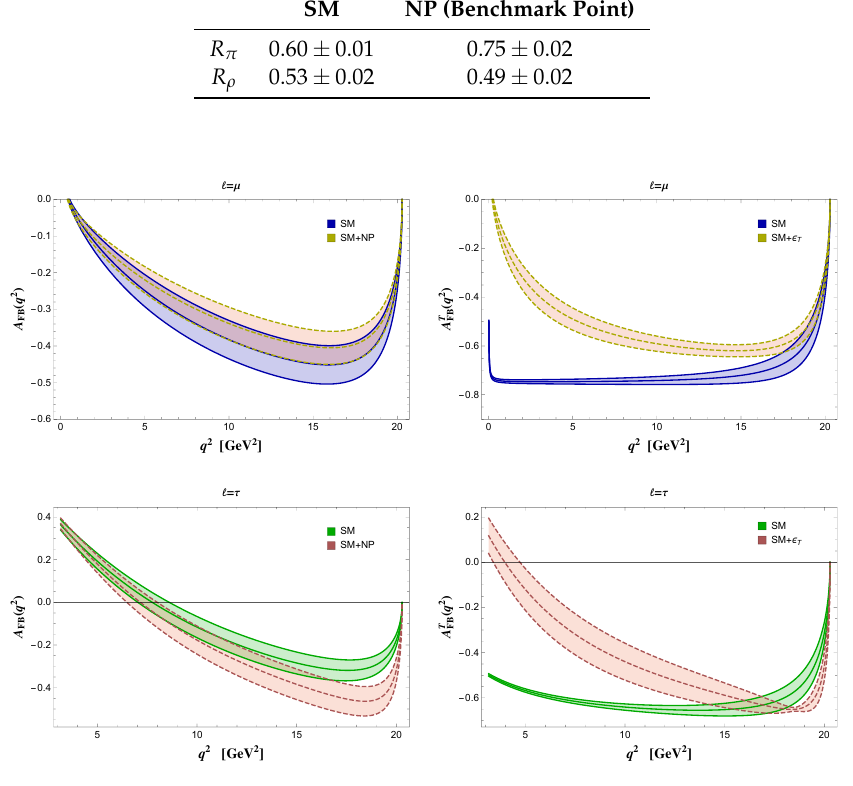
Figure 11. Forward-backward (FB) lepton asymmetries (11) ( left ) and (13) ( right ) for ¯ B → ρ µ − ¯ ν µ ( top line ) and ¯ B → ρ τ − ¯ ν µ ( bottom line